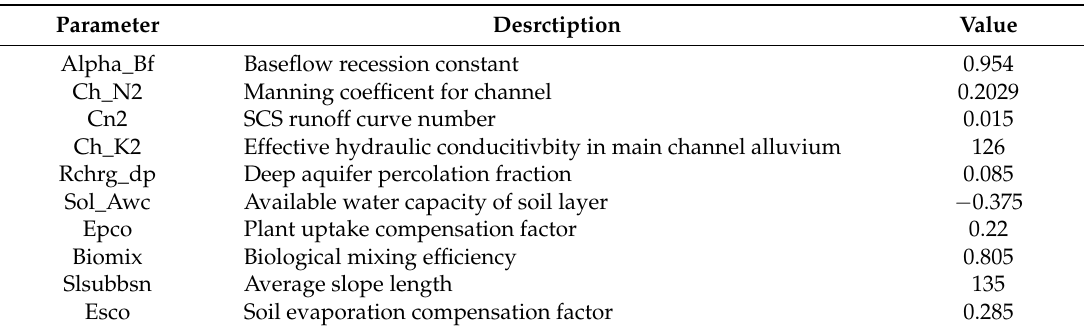
Figure 2. Observed and simulated total flow from January 2013 to September 2018. Table 1. Calibrated parameter set.